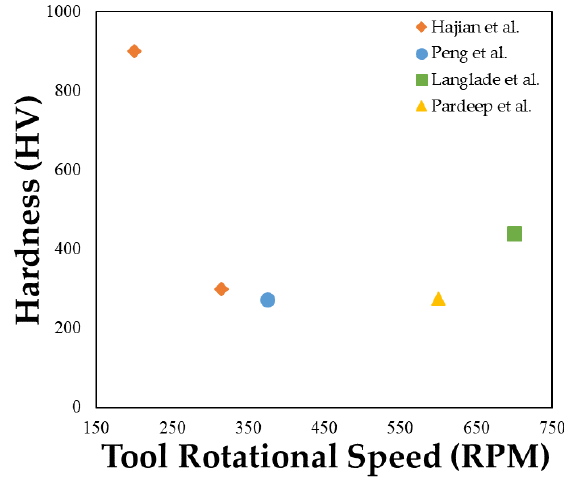
Figure 8. Relationship between hardness and tool rotational speed adapted from the work of Hajian et al., Peng et al., Langlade et al. and Pardeep et al. [44,66,80,81].